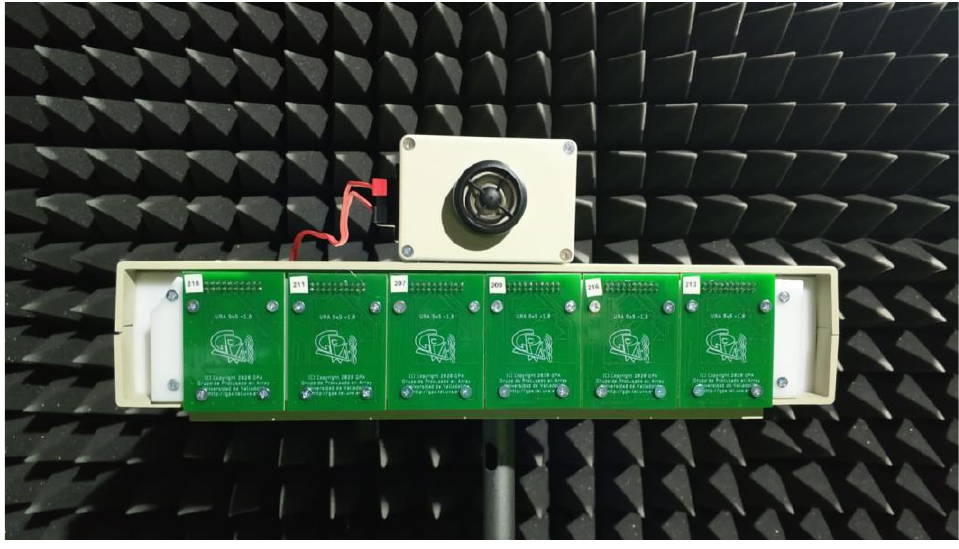
Figure 1. System MEMS array.